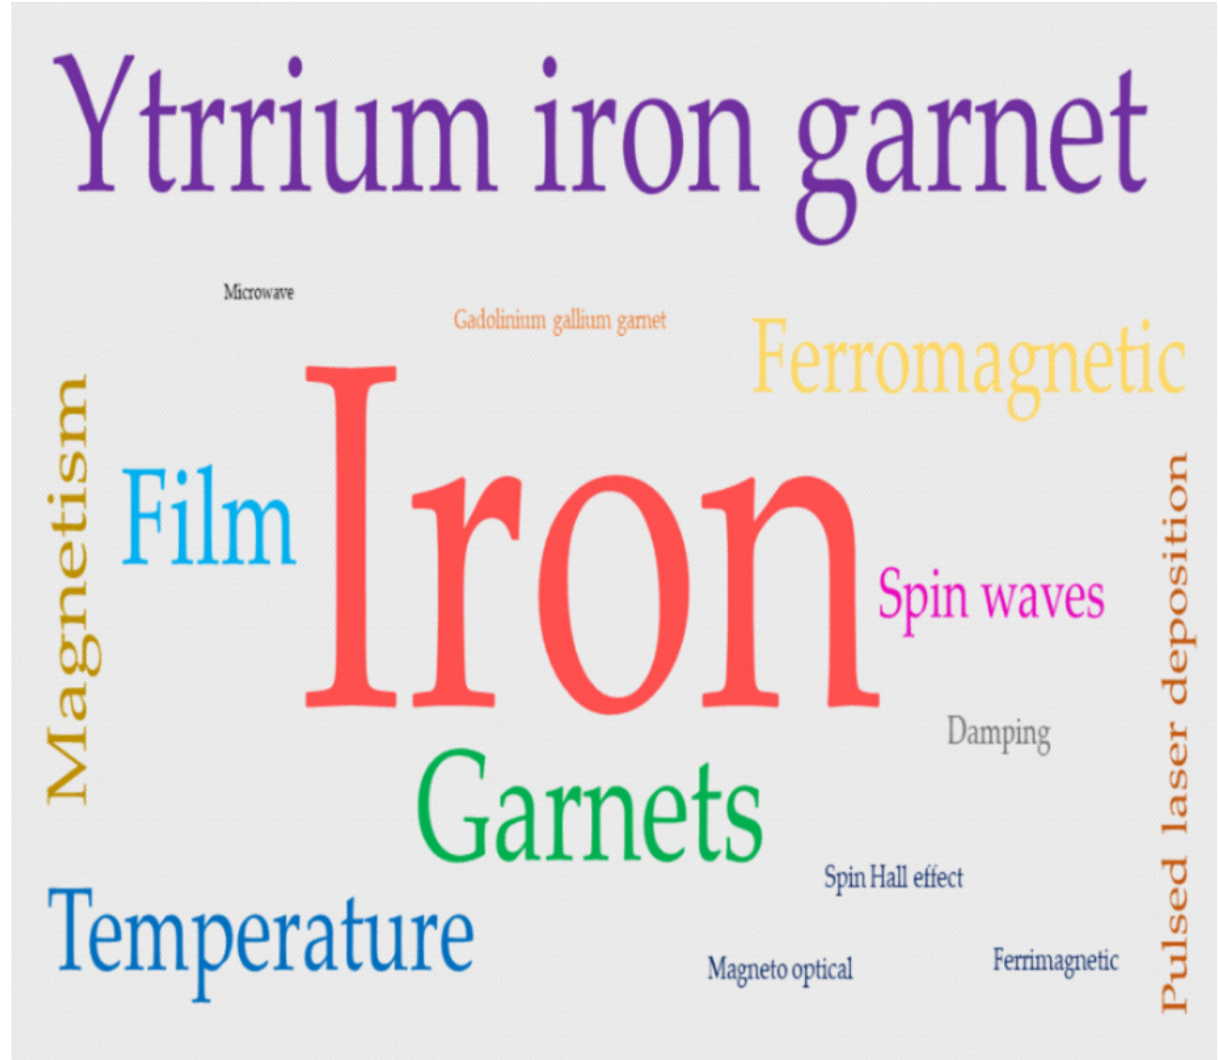
Figure 7. Popular keywords in the top 100 cited articles.